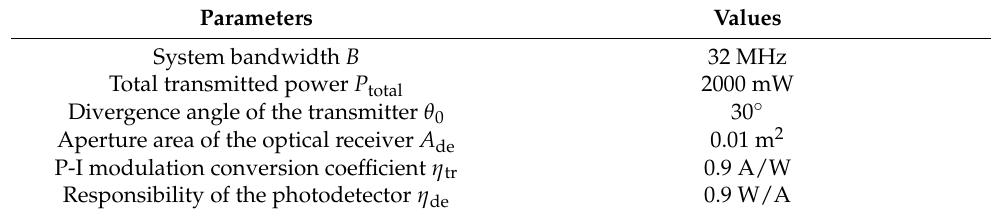
Table 4. Simulation